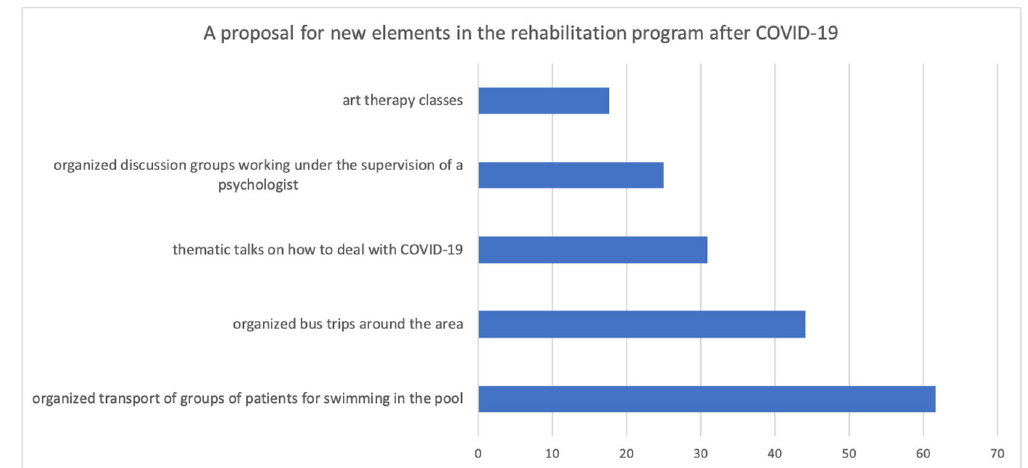
Figure 4. A proposal for new elements in the rehabilitation program after COVID ‐ 19.